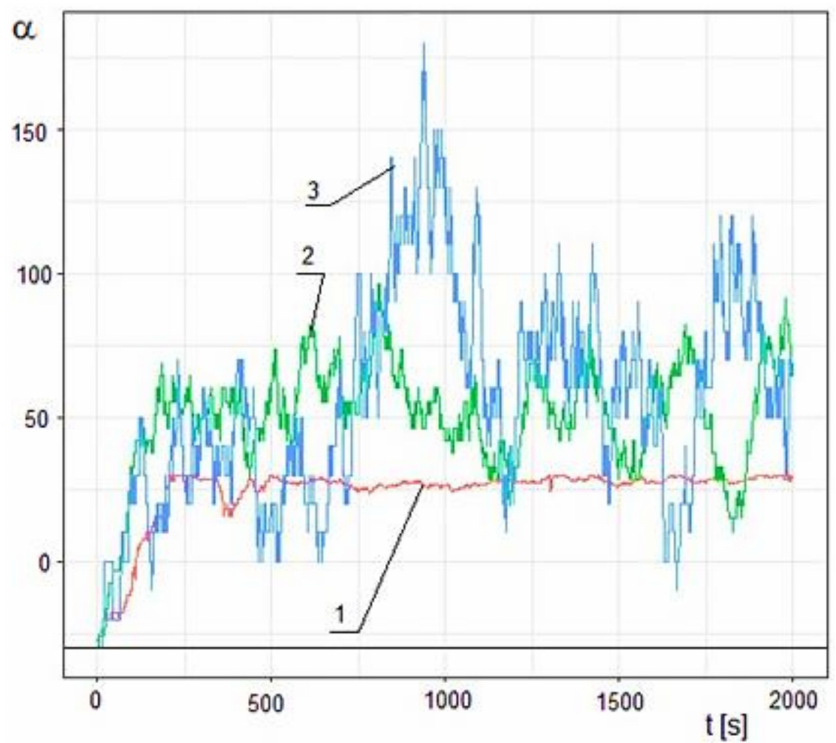
Figure 5. Simulation of gains α for the values µ 1 = 0.004, µ 2 = 0.009, and µ 3 = 0.02 and λ = 0. The horizontal line crossing the OY axis in the value ( − 30) determines the fixed cost of maintaining the